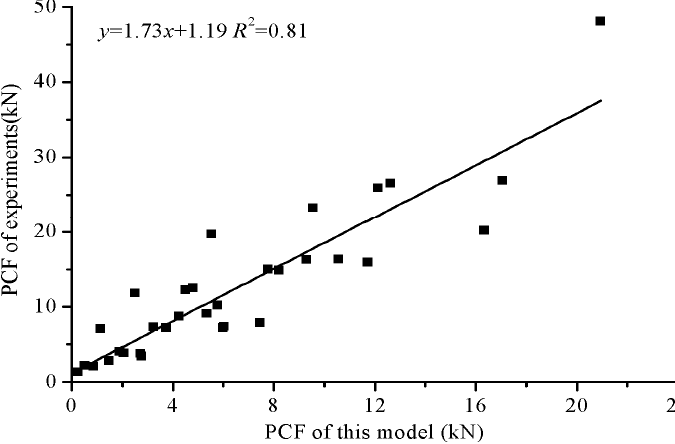
Figure 8: The relationship between the predicted and experimental PCF.